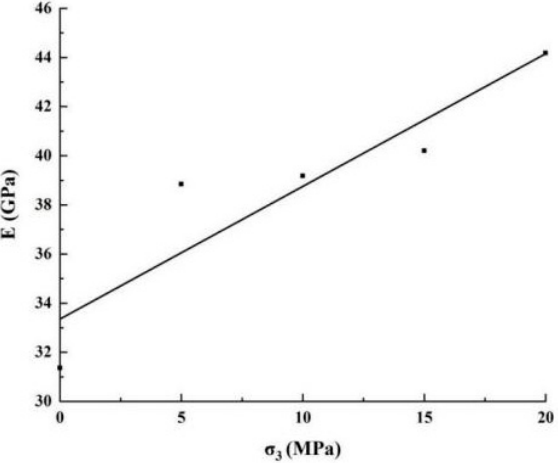
Figure 6. The curve of elastic modulus E changes with confining pressure.